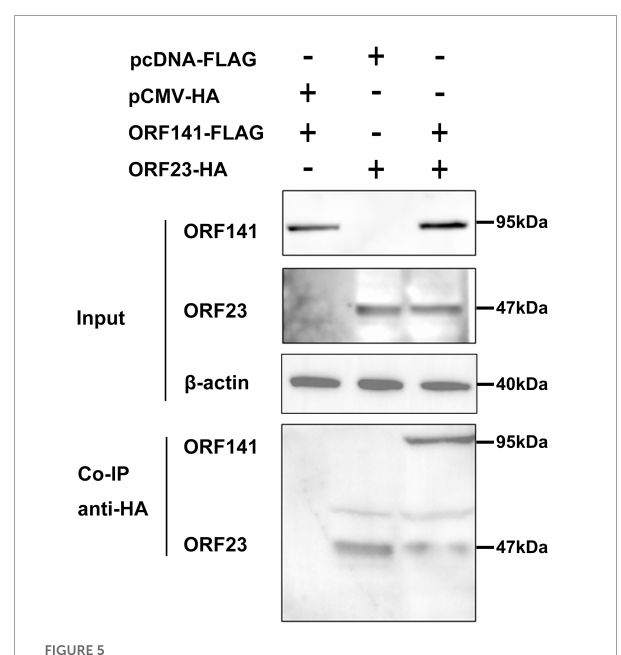
silencing of ORF23 and ORF141 expression can significantly inhibit the replication of CyHV-2 ( Figure 7 ).